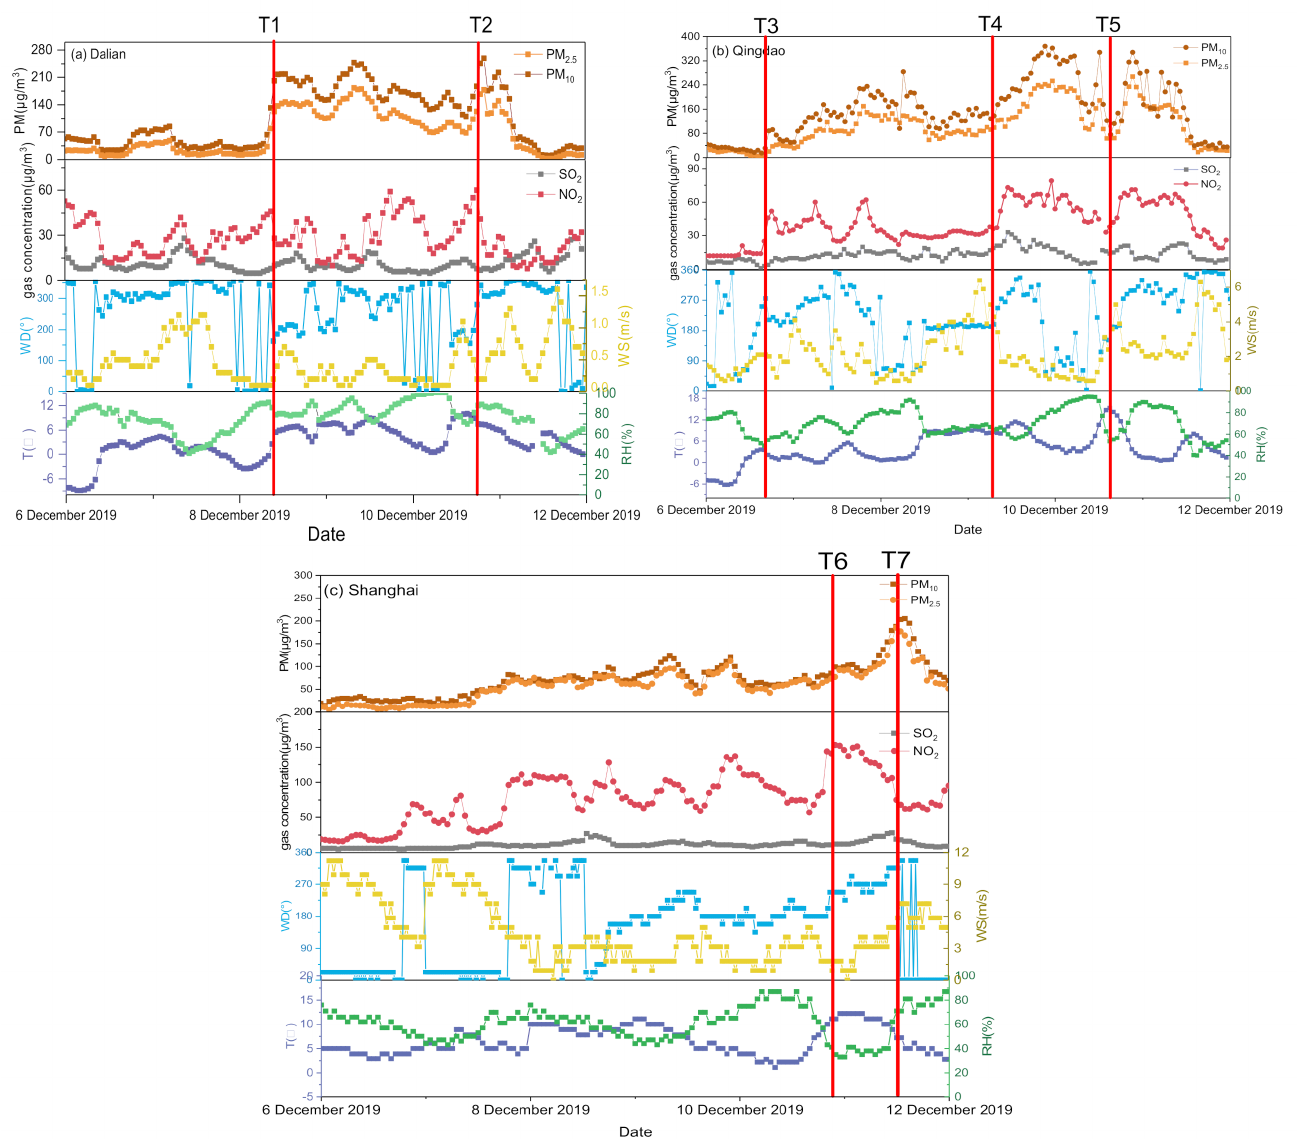
Figure 10. PM 2.5 , PM 10 , NO 2 , SO 2 , wind direction (WD), wind speed (WS), temperature (T) and relative humidity (RH) in Dalian ( a ), Qingdao ( b ), and Shanghai ( c ) from 6 December 2019 to 11 December